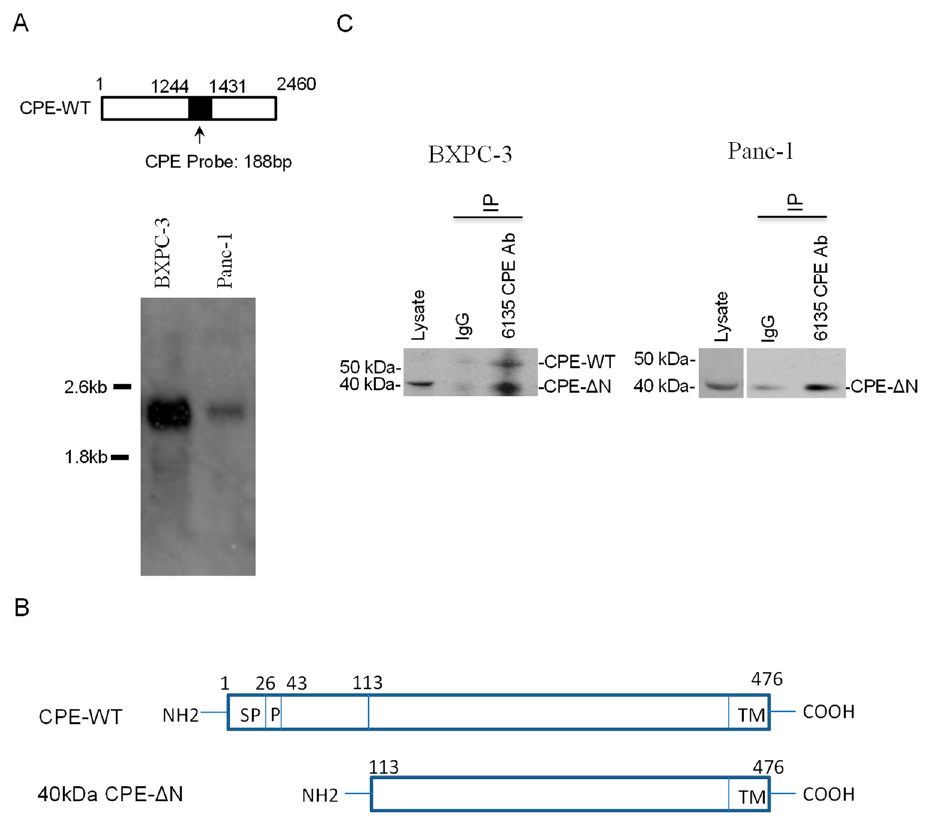
Figure 1. Expression of the carboxypeptidase E (CPE) variant transcripts and proteins in human pancreatic cancer cells. ( A ) Upper panel: Schematic representation of the DIG-labeled CPE probe (shaded box). The numbers refer to the probe covering the region in human CPE mRNA. Lower panel: Northern Blot showing CPE transcripts detected in BXPC-3 and Panc-1. ( B ) Schematic representation of the alignment of deduced amino acid sequences of homo sapiens CPE NM001873.2, CPE-WT, and its variant 40 kDa CPE- ∆ N; the 40 kDa CPE- ∆ N lacks 112 aa at the N-terminus. Numbers refer to the amino acid positions in CPE protein. SP, signal peptide; P, propeptide; TM, transmembrane domain. ( C ) Western blot using anti-CPE mouse monoclonal antibody showing the expression of endogenous CPE-WT and / or CPE- ∆ N in BXPC-3 (left panel) and Panc-1 (right panel) cell lysate immunoprecipitated with either rabbit polyclonal anti-CPE specific antibody (6135) or rabbit IgG as control. Non-immunoprecipitated cell lysate of Panc-1 was present in the same blot, separated by two lanes, and developed with longer exposure. Full-length blots are presented in Supplementary Figure S1.